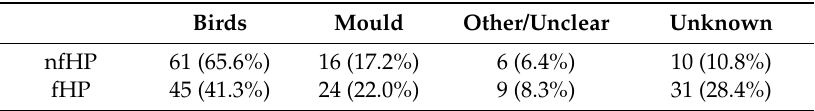
Table 2. Frequency of exposure types based on HP subtype. fHP patients had more often mould on total patient counts of the HP subgroup.